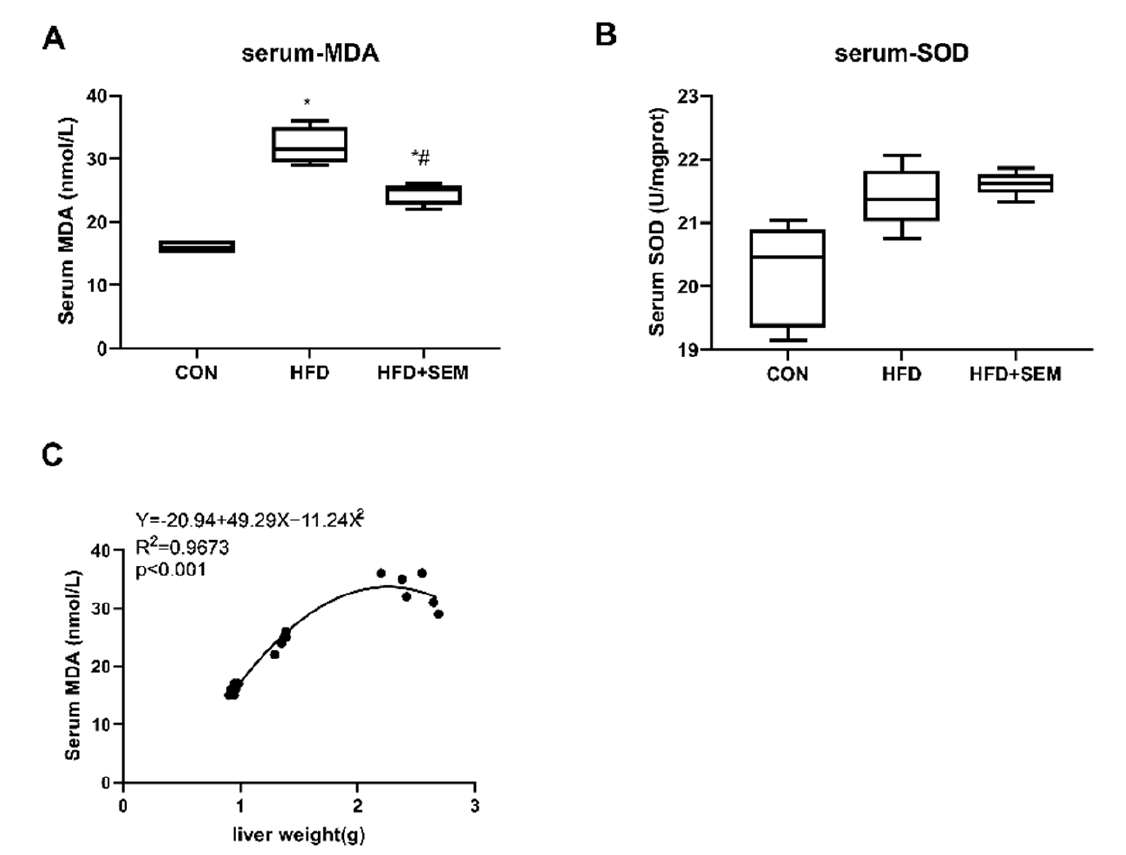
Figure 2. SEM treatment ameliorates hepatic steatosis-associated systemic oxidative stress. Effects of HFD and HFD + SEM on ( A ) serum MDA levels, ( B ) serum SOD levels, and ( C ) correlation of serum MDA levels with liver weight. Box-and-whisker diagrams are presented as min to max and were analyzed with one-way ANOVA; * vs. control group ( p ≤ 0.05); # indicates significantly different when comparing mice fed HFD alone vs. mice fed HFD + SEM ( p ≤ 0.05). Correlation data ( C ) are fitted to a second-order polynomial. Equation, r 2 and p -value are shown in the left upper corner. Statistical analysis was performed by the Spearman’s rank correlation test; p ≤ 0.05 shows a statistically significant relation.